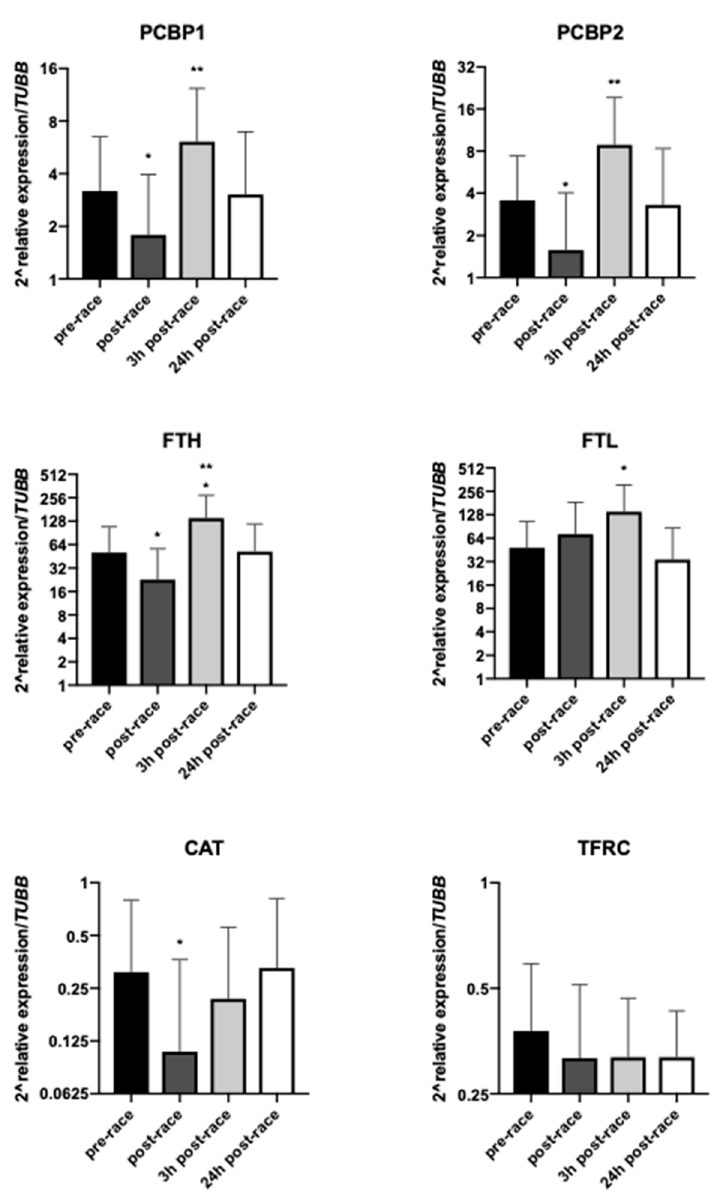
Figure 3. mRNA levels of selected genes at di ff erent time points ( n = 24). Values are presented as mean ± SD. * p < 0.05 compared to the pre-race value and ** p < 0.05 compared to the post-race value.